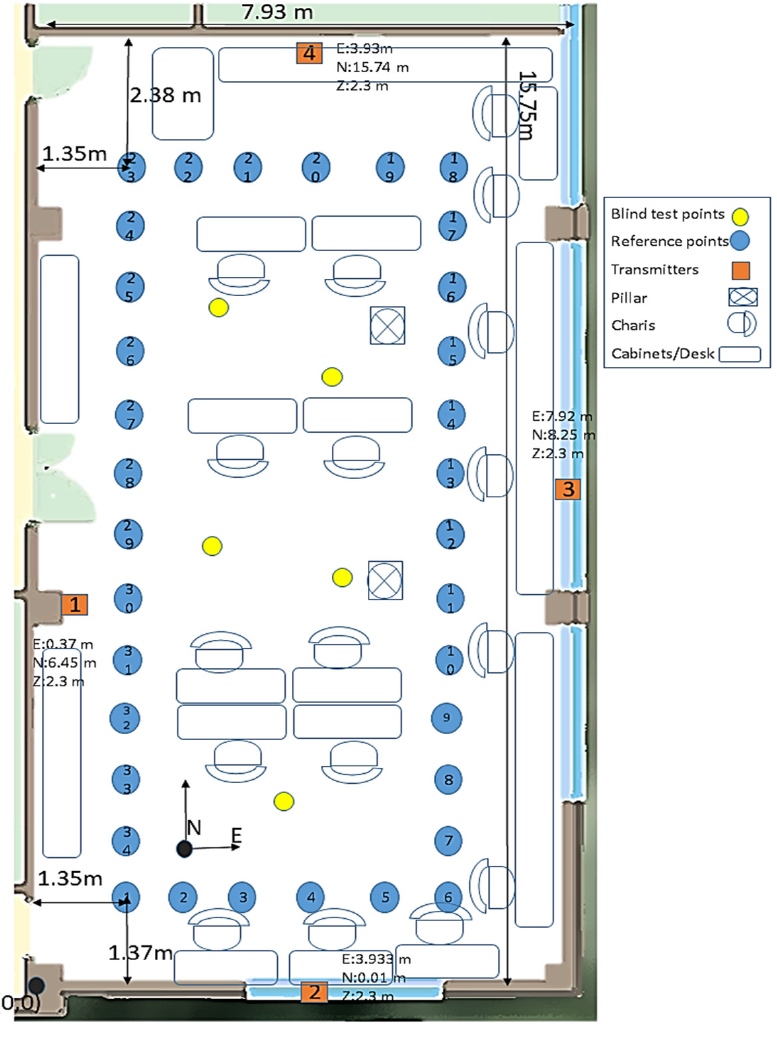
Figure 10. Plan view of the test